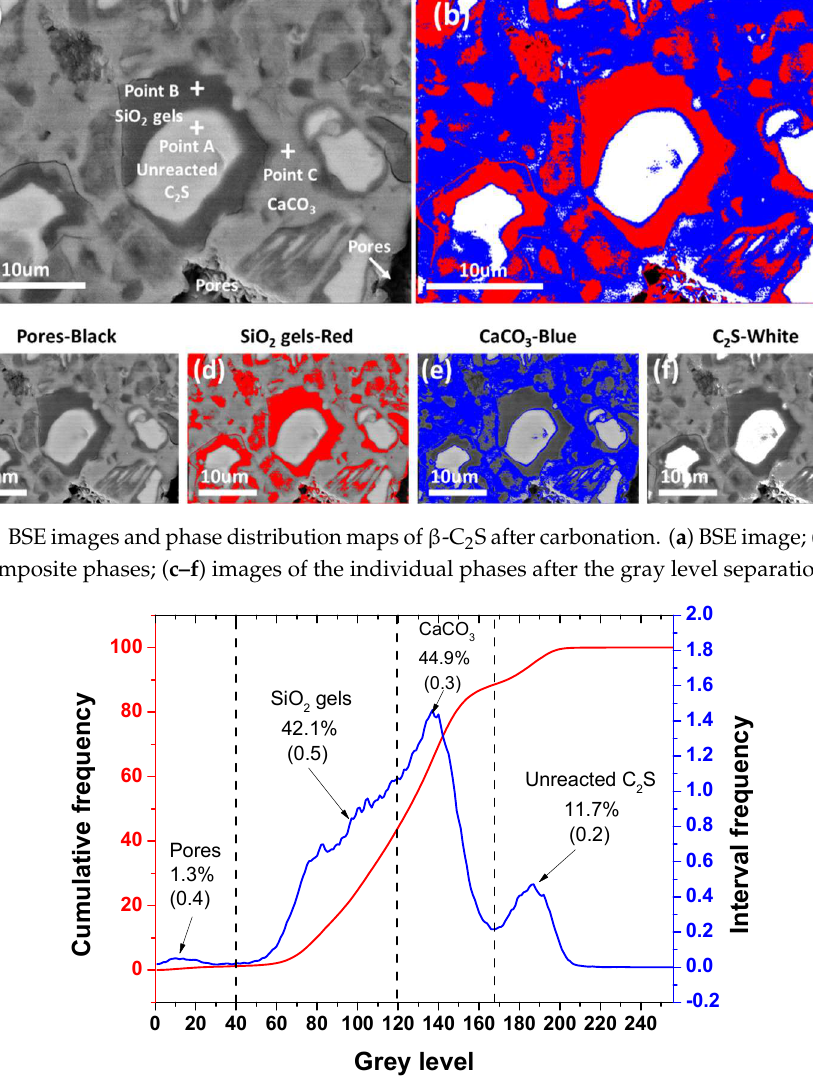
Figure 4. The gray level frequency and the cumulative distribution curves for different phases.